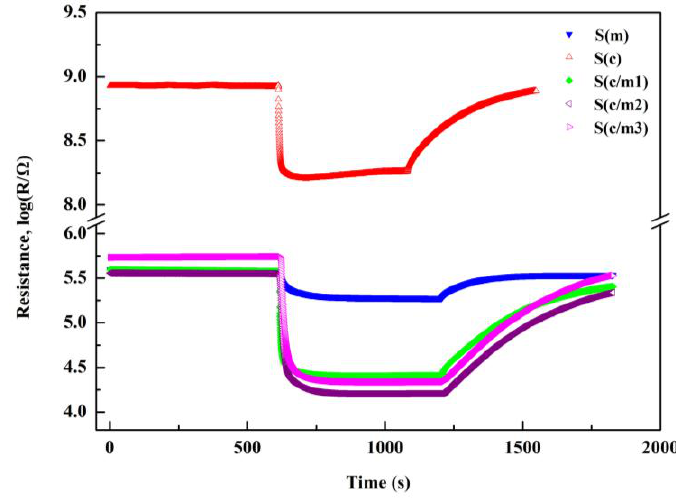
Figure 4. Response transients of the gas sensors to 1000 ppm H 2 at 400 °C.